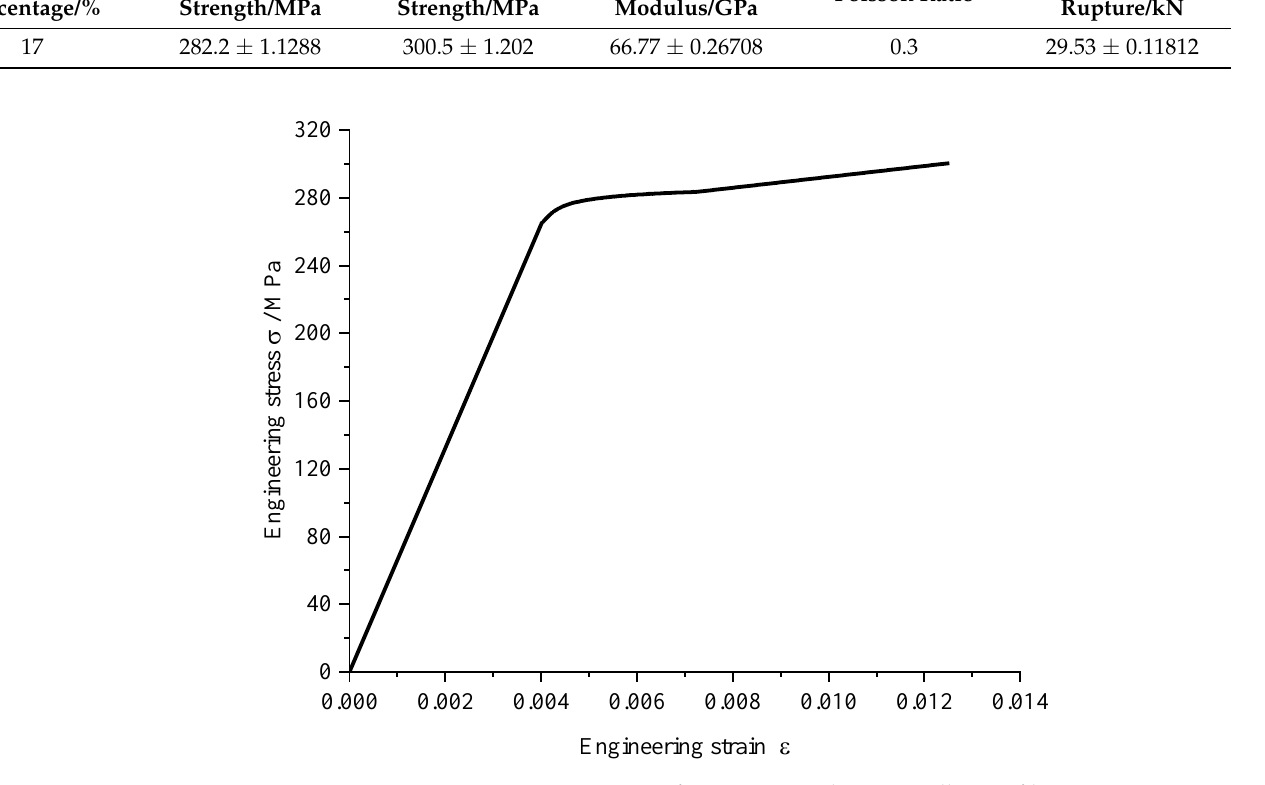
Figure 6. Engineering stress – strain curve of AL6005A-T6 aluminum alloy profile.